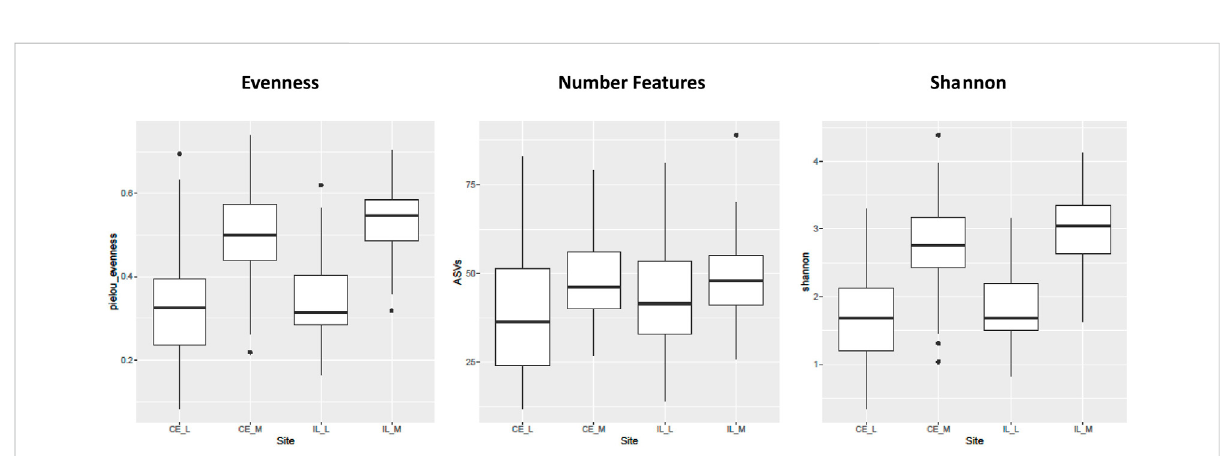
FIGURE 2 Boxplots ofall themaineffects ofall threealphadiversity metrics acrosssites.Alpha diversity isgreater inluminal(CE_L,IL_L)than mucosal (IL_ M, IL_M) samples. Plot de fi nitions as in Figure